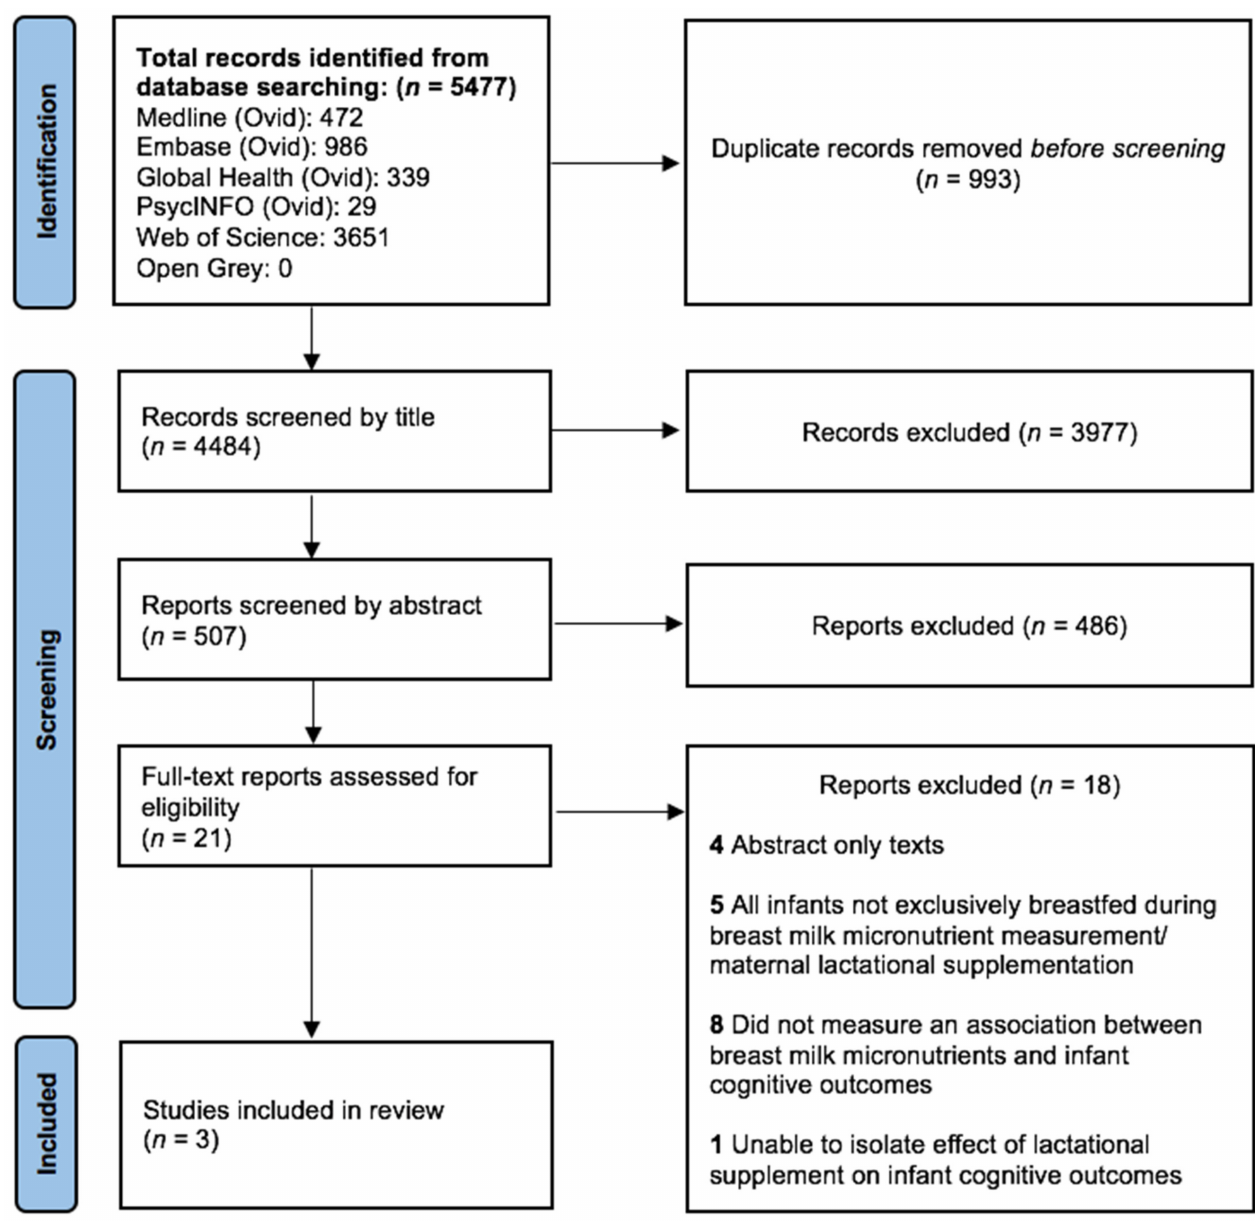
Figure 1. PRISMA flowchart of study